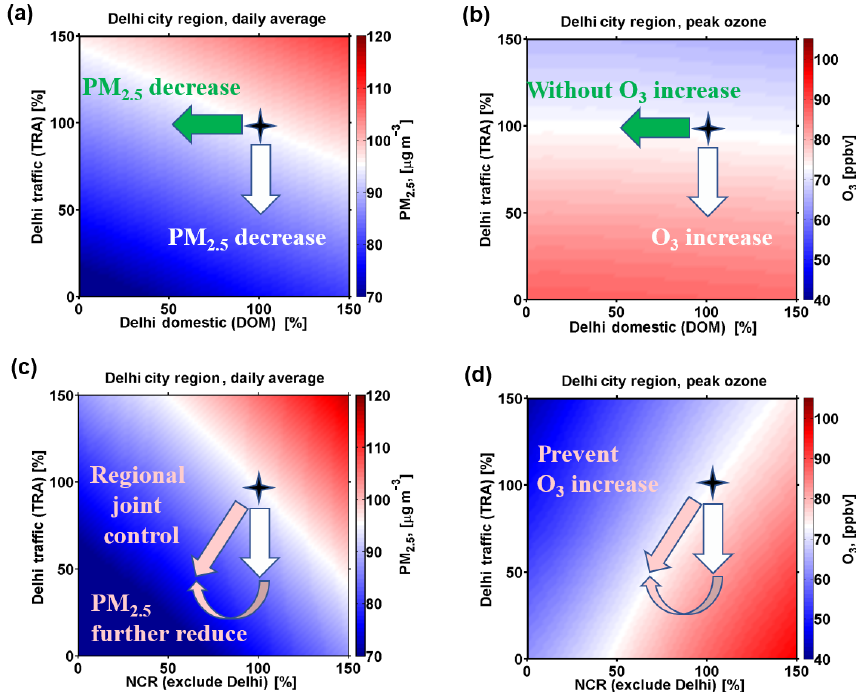
Figure 7. Response surfaces for PM 2 . 5 and ozone concentrations over Delhi city region, averaged over 2–15 May 2018. (a) Daily average of PM 2 . 5 concentrations as a function of local traffic and domestic emissions in Delhi, (b) peak hourly ozone concentrations as a function of local traffic and domestic emissions in Delhi, (c) daily average of PM 2 . 5 concentrations as a function of local traffic emissions in Delhi and emissions in NCR region surrounding Delhi, and (d) peak hourly ozone concentrations as a function of local traffic emissions in Delhi and emissions in NCR region surrounding Delhi. The star indicates current conditions, and the arrows show the effect of possible emission